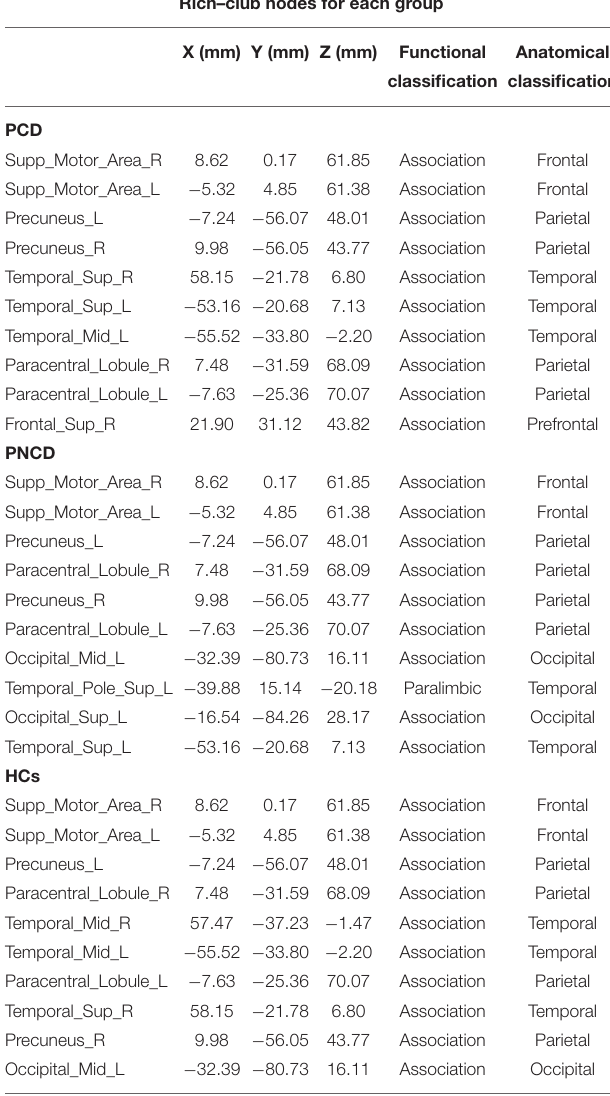
TABLE 3 | Rich–club nodes for each group. Rich–club nodes for each